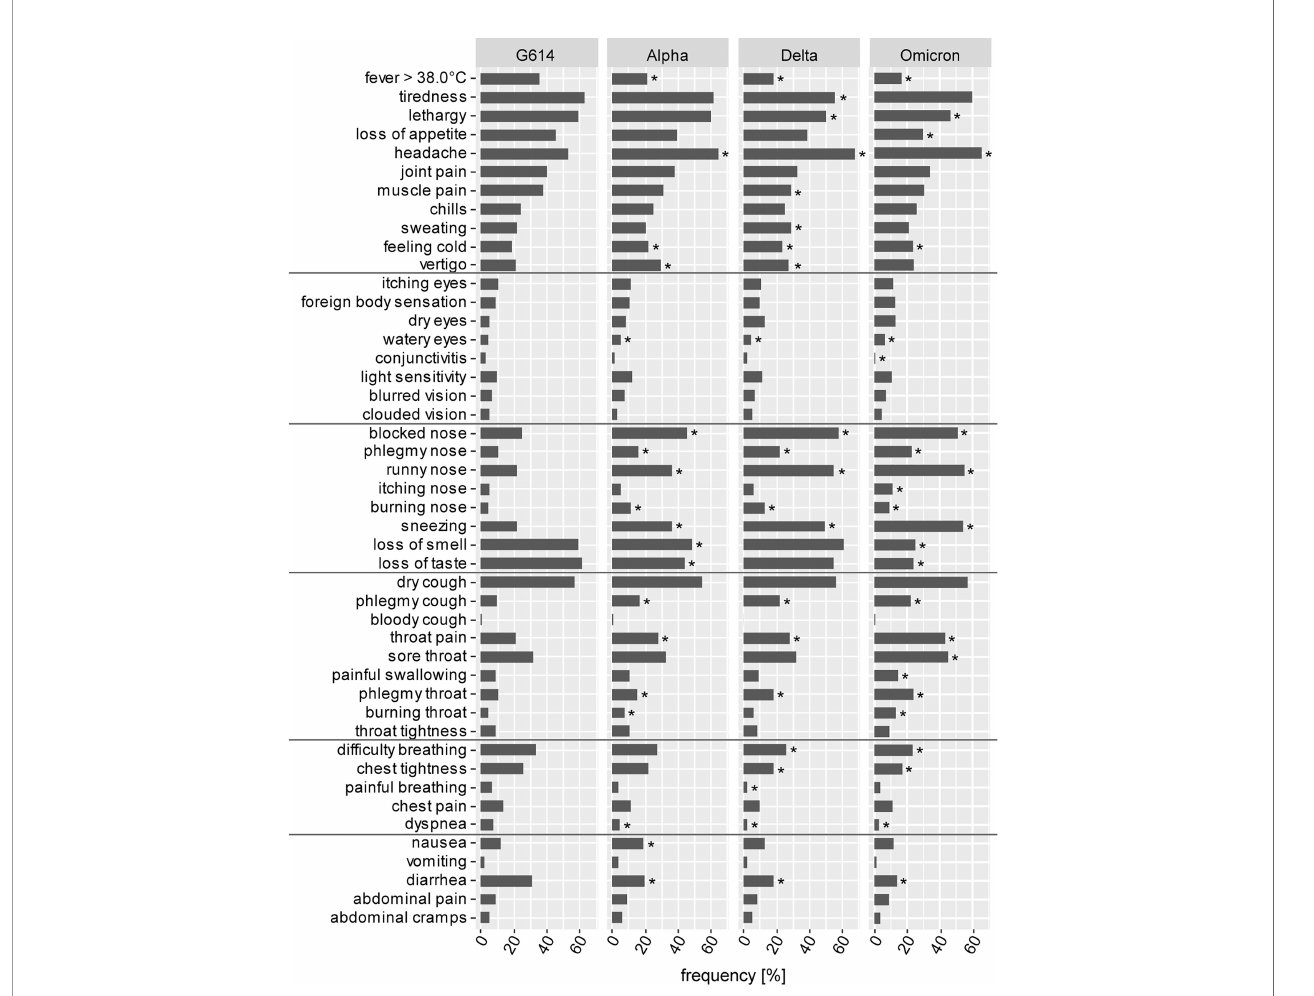
FIGURE 2 | Frequencies of symptoms. Frequencies for each symptom were calculated for SARS-CoV-2 positive individuals from G614, alpha variant, delta variant and omicron variant dominated phases of the SARS-CoV-2 pandemic. Statistically signi fi cant differences compared to the frequencies in the G614 phase are indicated by * ( p < 0.05, Fisher ’ s exact